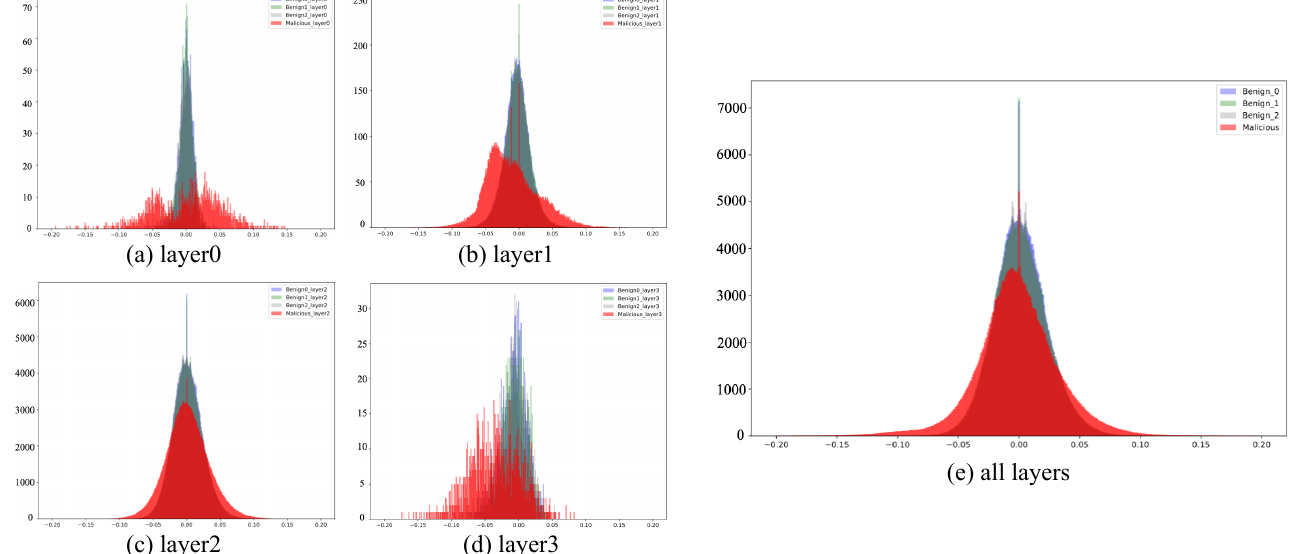
Figure 7. A comparison of weight update distributions for benign and malicious clients. ( a – d ) show the first four layers of neural network weight update distributions, ( e ) shows all